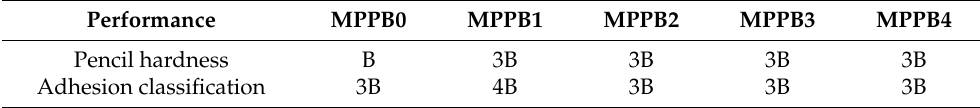
Table 2. Pencil hardness and adhesion classification of the transparent fire-retardant coatings.